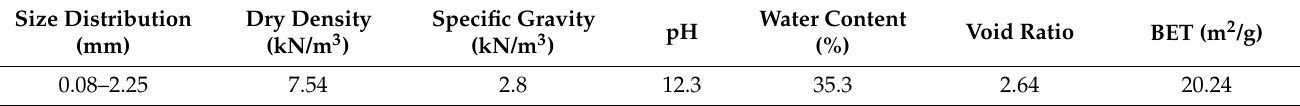
Table 1. Basic physical properties of red mud.